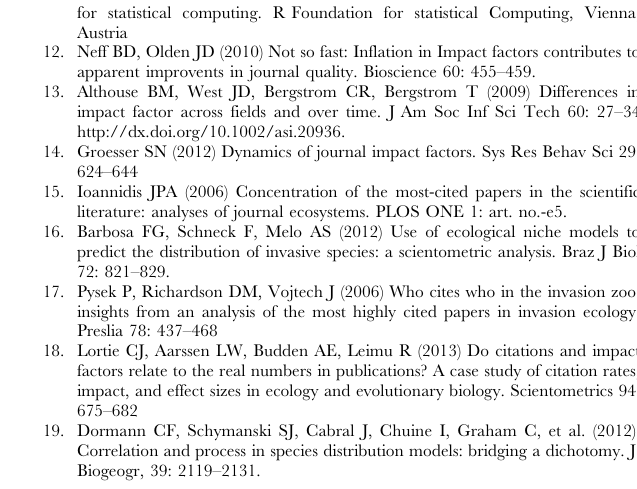
Table S1 Bibliometric information compiled on jour- nals used in the analyses of the impact of species distribution modelling (SDM) on changes in the journals impact factor index (IF).